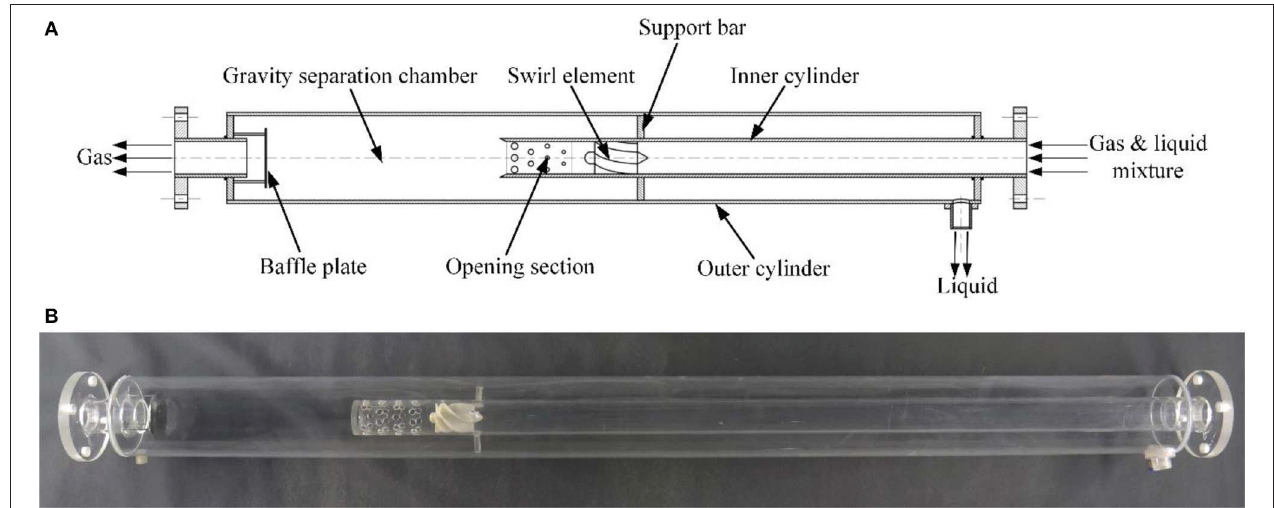
FIGURE 1 | The configuration of the gas-liquid separator. (A) Section view of the separator. (B) Physical map of the